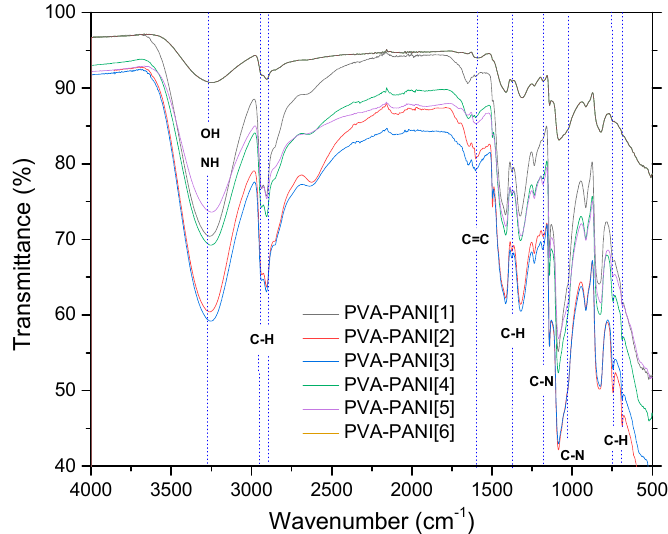
Figure 4. FTIR spectra of PVA–PANI gels at different PANI concentrations.